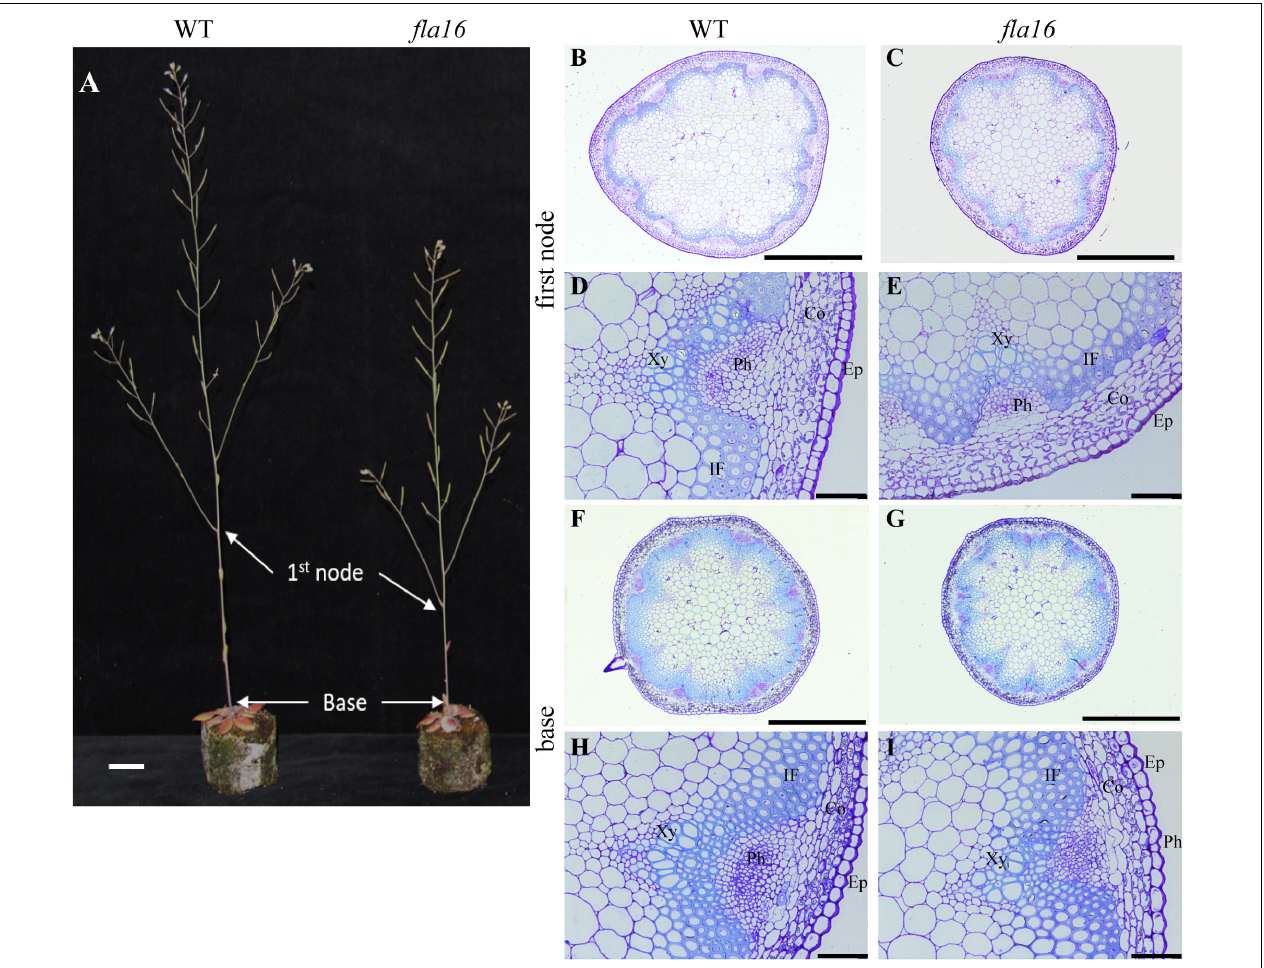
FIGURE 2 | Stem phenotypes of WT and fla16 mutants at maturity. (A) Representative image of WT and fla16 mutants grown to post-maturity [growth stage 6.9 (Boyes et al., 2001)] shows the reduced total stem and first internode lengths of fla16 compared to WT. Toluidine blue staining of transverse sections of stems of WT (B,D,F,H) and fla16 (C,E,G,I) at the base and first internode in mature stems (growth stage 6.5) shows the reduced stem diameter in fla16 compared to WT and no obvious differences in cellular organization. Epidermis (Ep), cortex (Co), phloem (Ph), interfascicular fiber (IF), and Xylem (Xy). Scale bar = 2 cm in (A) , 500 µ m in (A,B,F,G) and 50 µ m in (D,E,H,I)